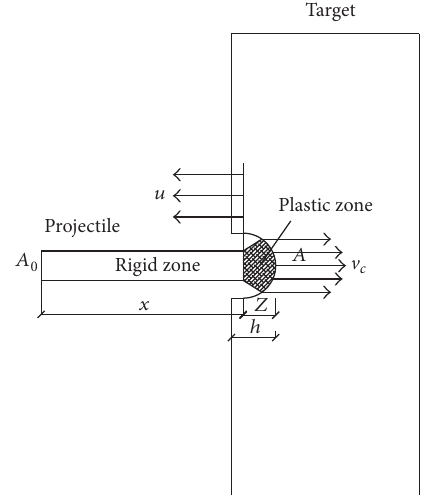
Figure 10: One-dimensional simplified diagram of modified Taylor